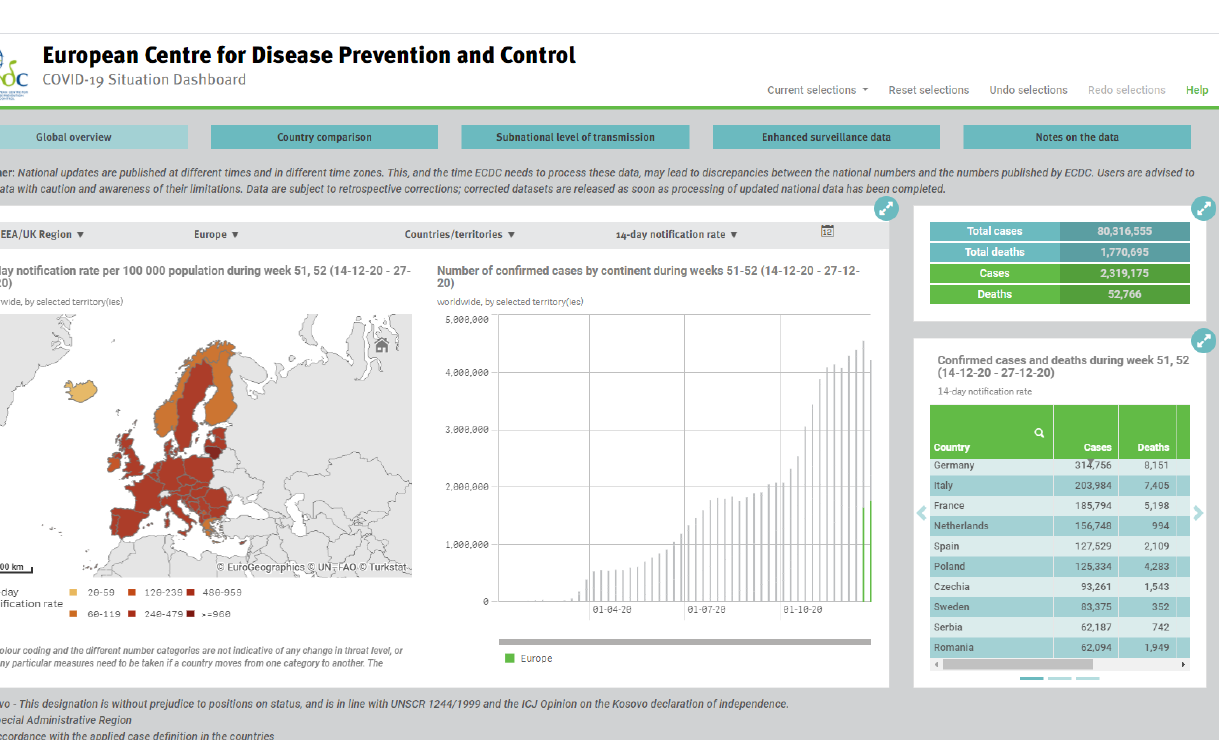
Figure 1. European distribution of COVID-19 cases, 14-day notification rate per 100,000 population in week 5–051 (Source: European Centre for Disease Prevention and Control [12]), https://qap.ecdc.europa.eu/public/extensions/COVID-19/COVID-19.html (accessed on December 2020).